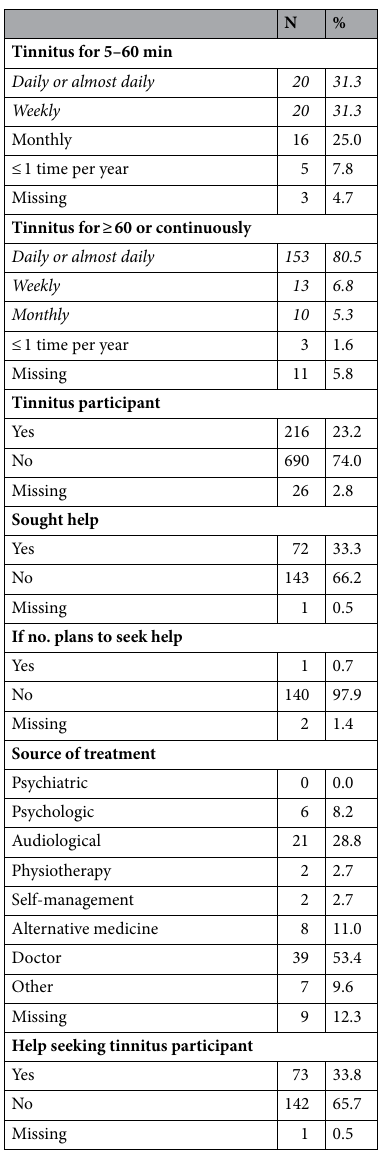
Table 2. Tinnitus participants and help seeking participants with tinnitus. Tinnitus participant were defined as experiencing tinnitus for 5–60 min daily or almost daily, or weekly or 60 min or more or continuously daily or almost daily, weekly or monthly. (These are written cursive) Please see Supplementary Table S2 for answer to type of tinnitus help,